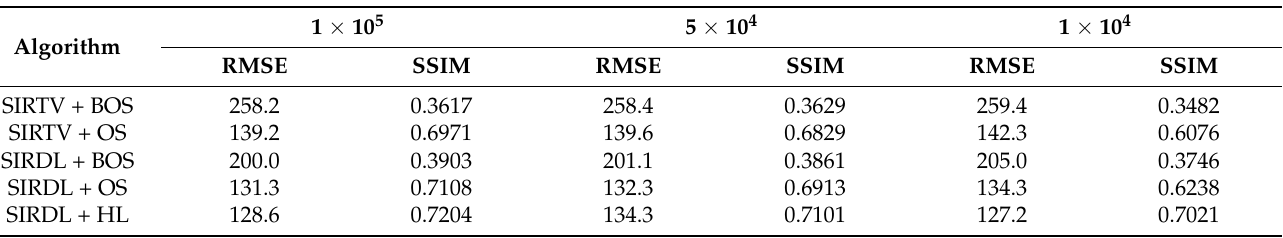
Table 1. RMSE (HU)/SSIM comparisons of the reconstructed ROI images from simulated projection using different